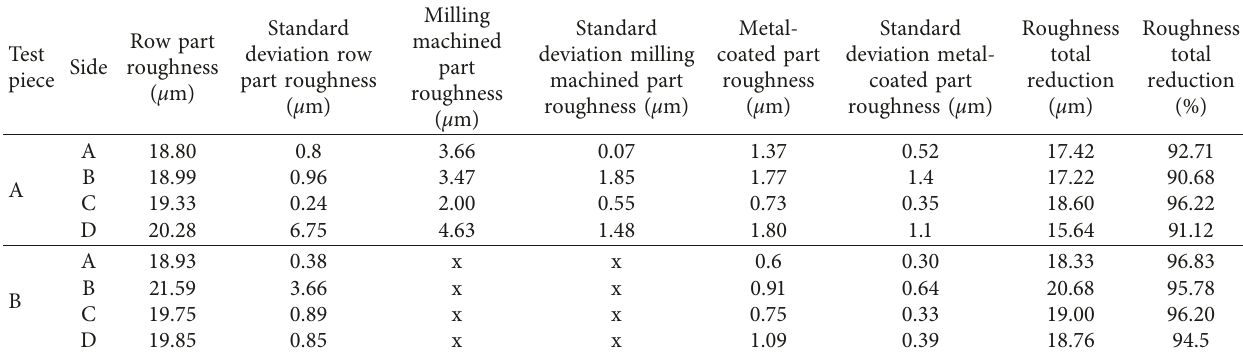
Table 2: Roughness values and comparison between row and treated part.